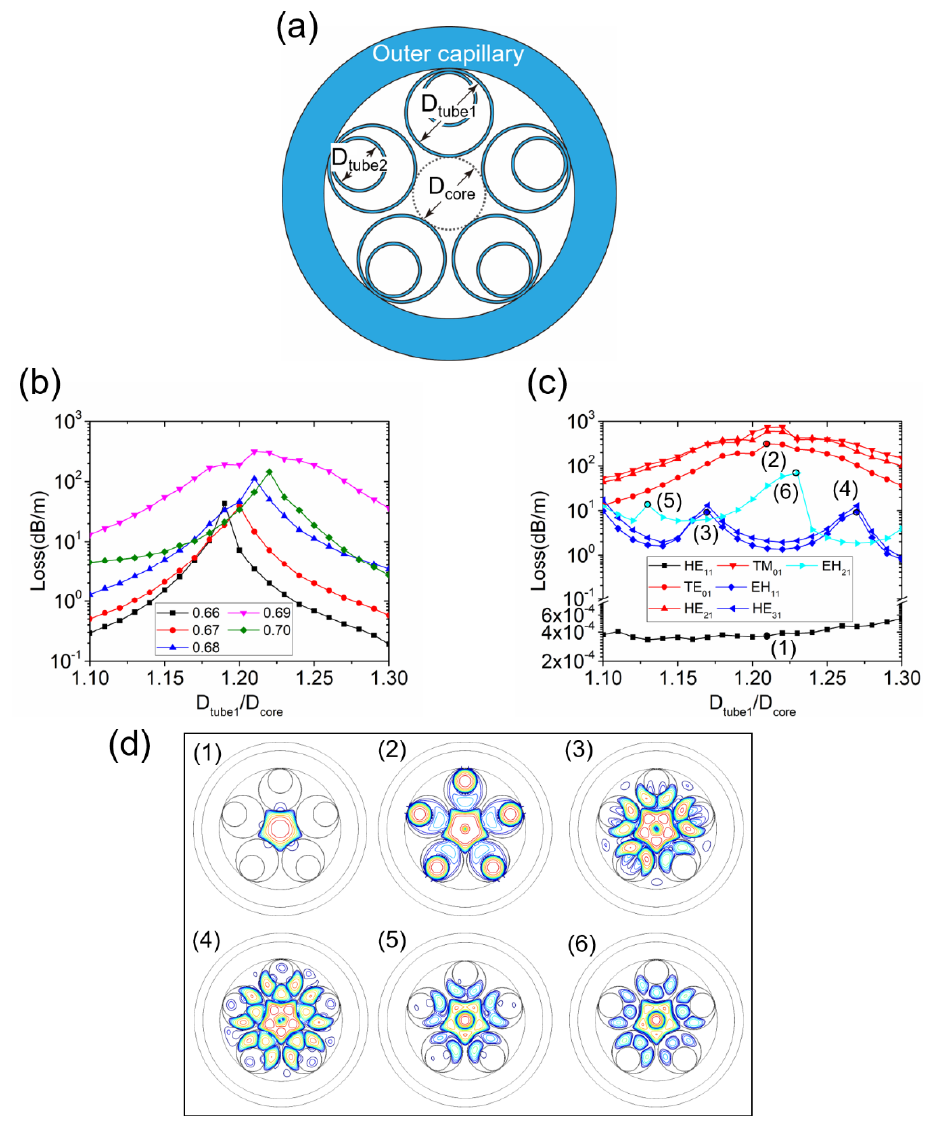
Figure 6. ( a ) Geometry of the NANF with five nested tubes. ( b ) The LP 11 (TE 01 ) mode loss as a function of D tube1 / D core for D tube2 / D core = 0.66, 0.67, 0.68, 0.69, and 0.70. ( c ) Simulated losses of the fundamental HE 11 mode and six HOMs (TE 01 , HE 21 , TM 01 , EH 11 , HE 31 , and HE 12 ) as a function of D tube1 / D core in the NANF with five nested tubes when D tube2 / D core = 0.69. ( d ) Three decibel (3-dB) contour lines of the mode patterns when D tube2 / D core = 0.69: (1) LP 01 modes when D tube1 / D core = 1.21, point (1) in ( c ); (2) LP 11 modes when D tube1 / D core = 1.21, point (2) in ( c ); (3) LP 21 modes when D tube1 / D core = 1.17, point (3) in ( c ); (4) LP 21 modes when D tube1 / D core = 1.27, point (4) in ( c ); (5) LP 02 modes when D tube1 / D core = 1.13, point (5) in ( c ); and (6) LP 02 modes when D tube1 / D core = 1.23, point (6) in ( c ).